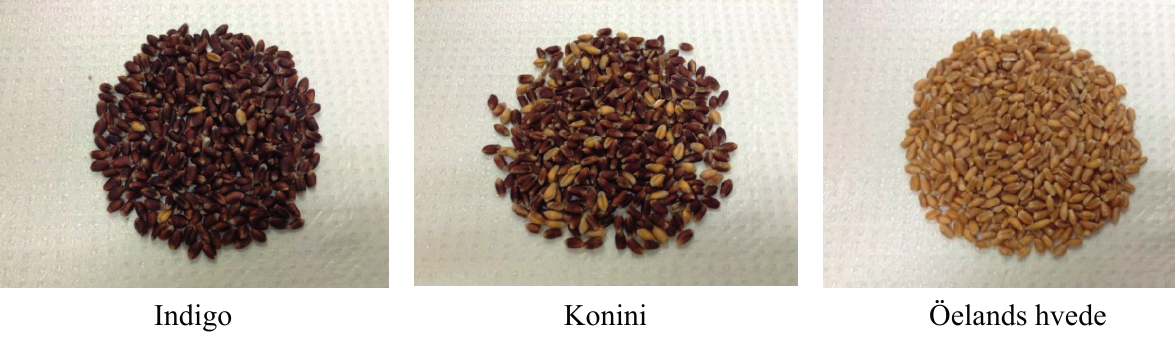
Figure 7. Photographs of whole wheat